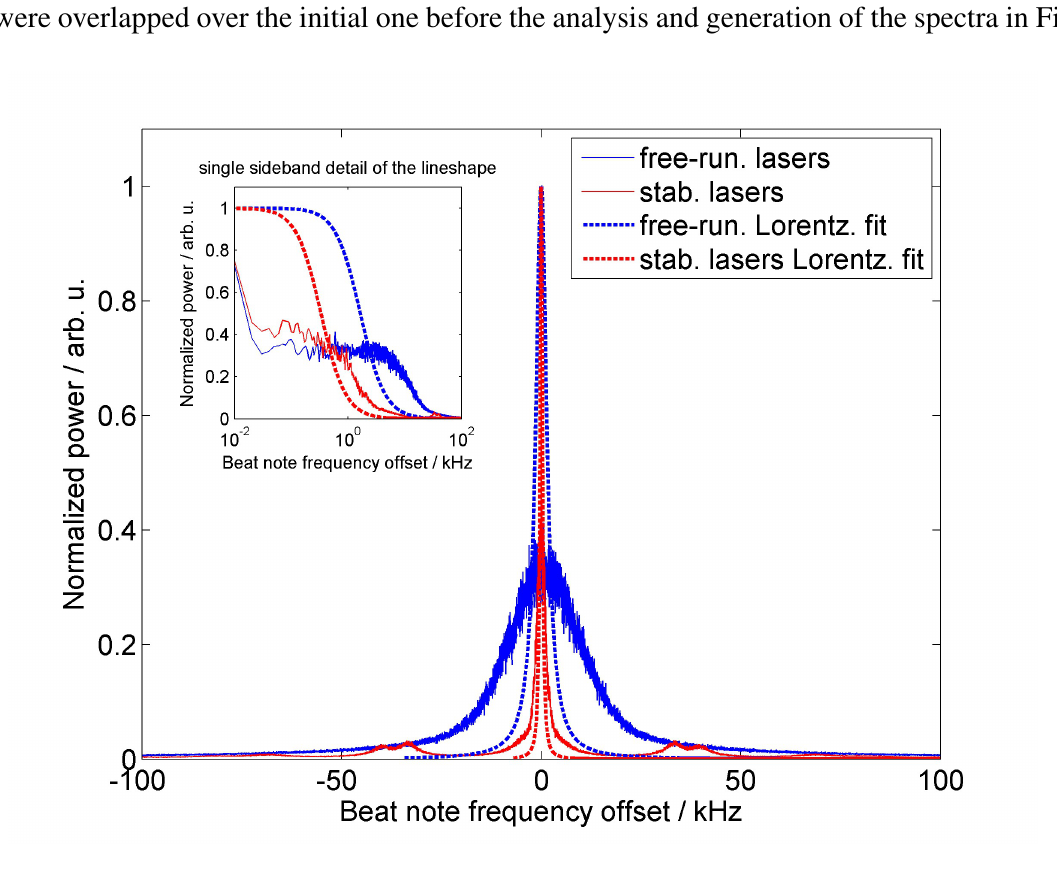
Figure 3. Normalized power spectra of the RF beat-note signal produced by mixing the optical outputs of two uncorrelated ORION laser modules. Free running lasers (“free-run.”) are represented by the blue line, whereas lasers stabilized to the unbalanced Michelson interferometer (“stab. lasers”) are red. Lorentzian function fits (“free-run. Lorentz. fit” for free running lasers and “stabl. lasers Lorentz. fit” for lasers stabilized to the unbalanced Michelson interferometer) for estimating the linewidth were supplemented to both datasets. Top left is the zoomed inset of the single-sideband normalized power spectra plot with logarithmic frequency